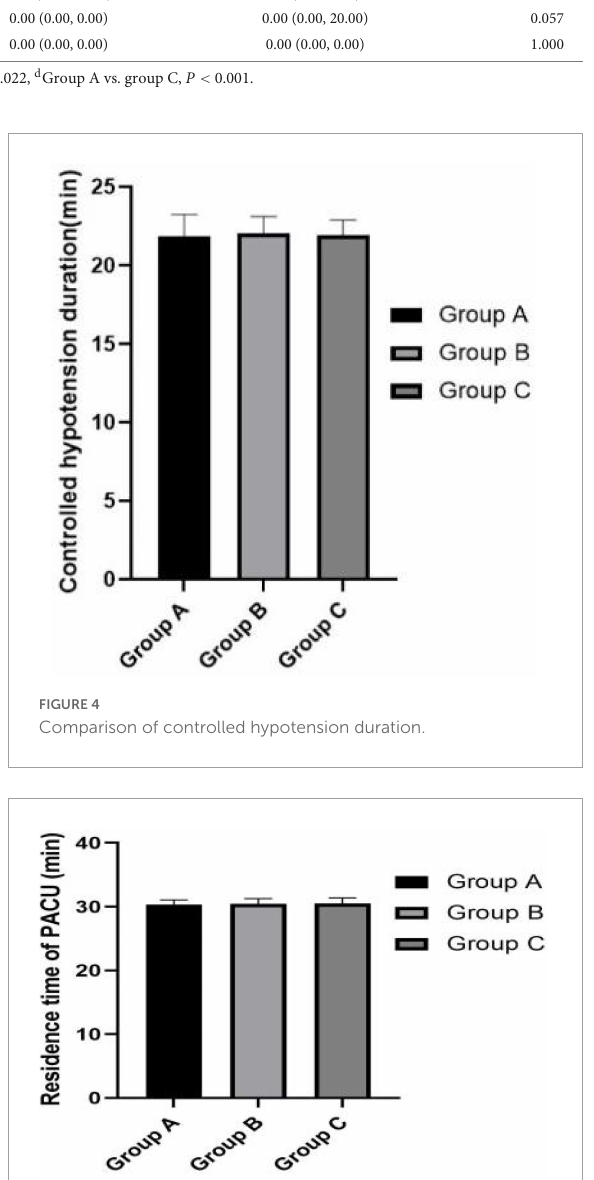
FIGURE5 Residence time of